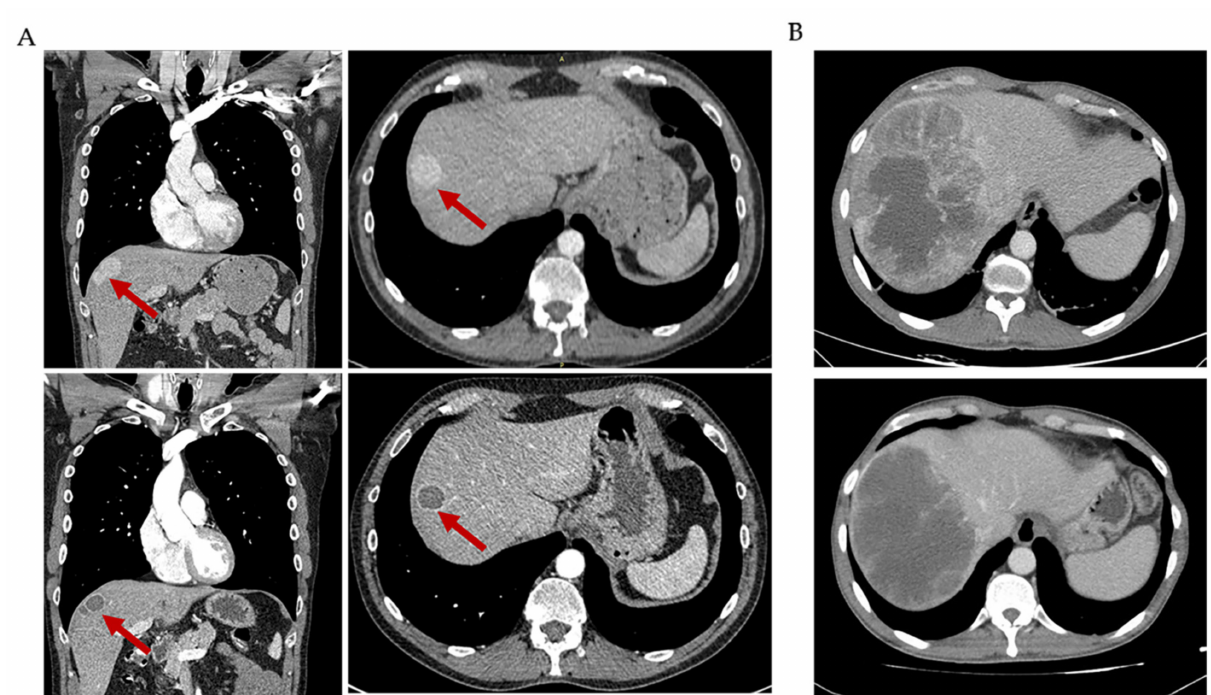
Figure 3. Choi responses to antiangiogenic agents in solitary fibrous tumor (SFT). ( A ) CT scan of an SFT patient showing a characteristic Choi partial response to pazopanib treatment in one hepatic lesion: decrease in density of 56%. ( B ) CT scan of an SFT patient showing a characteristic Choi partial response to pazopanib treatment in one hepatic lesion: decrease in density of